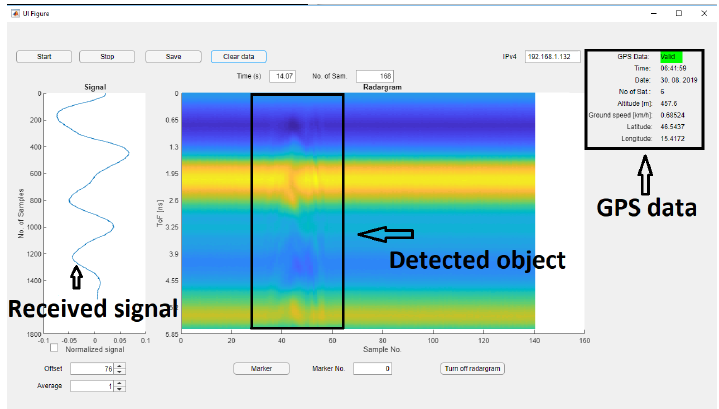
Figure 13. GUI of the radar. On the left side is a signal captured by the sampler. On the right side are captured signals joined into a figure